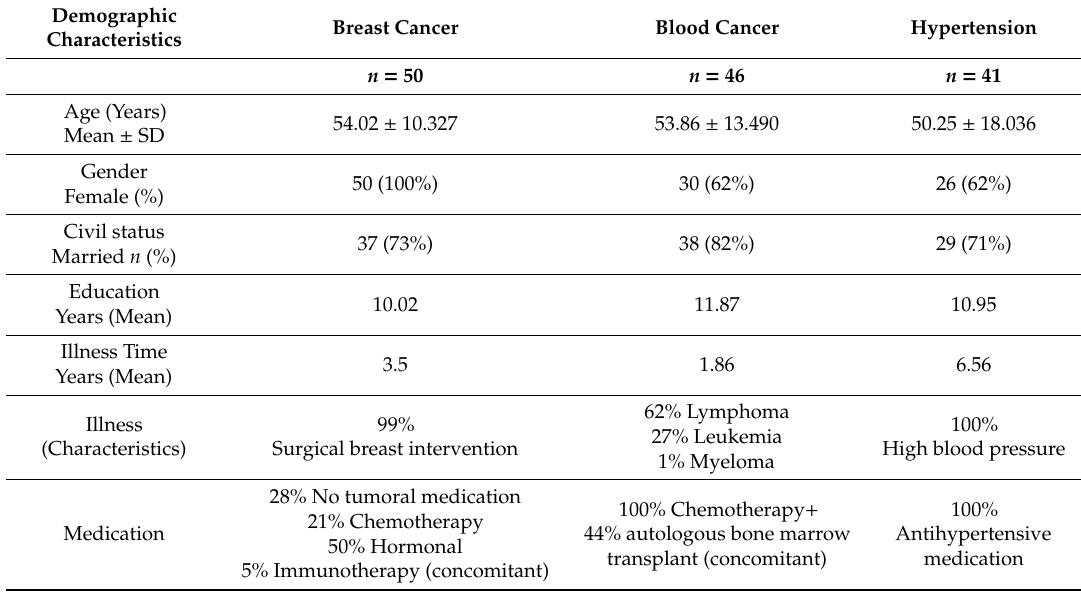
Table 2. Patients’ demographic characteristics and illness characteristics in illnesses